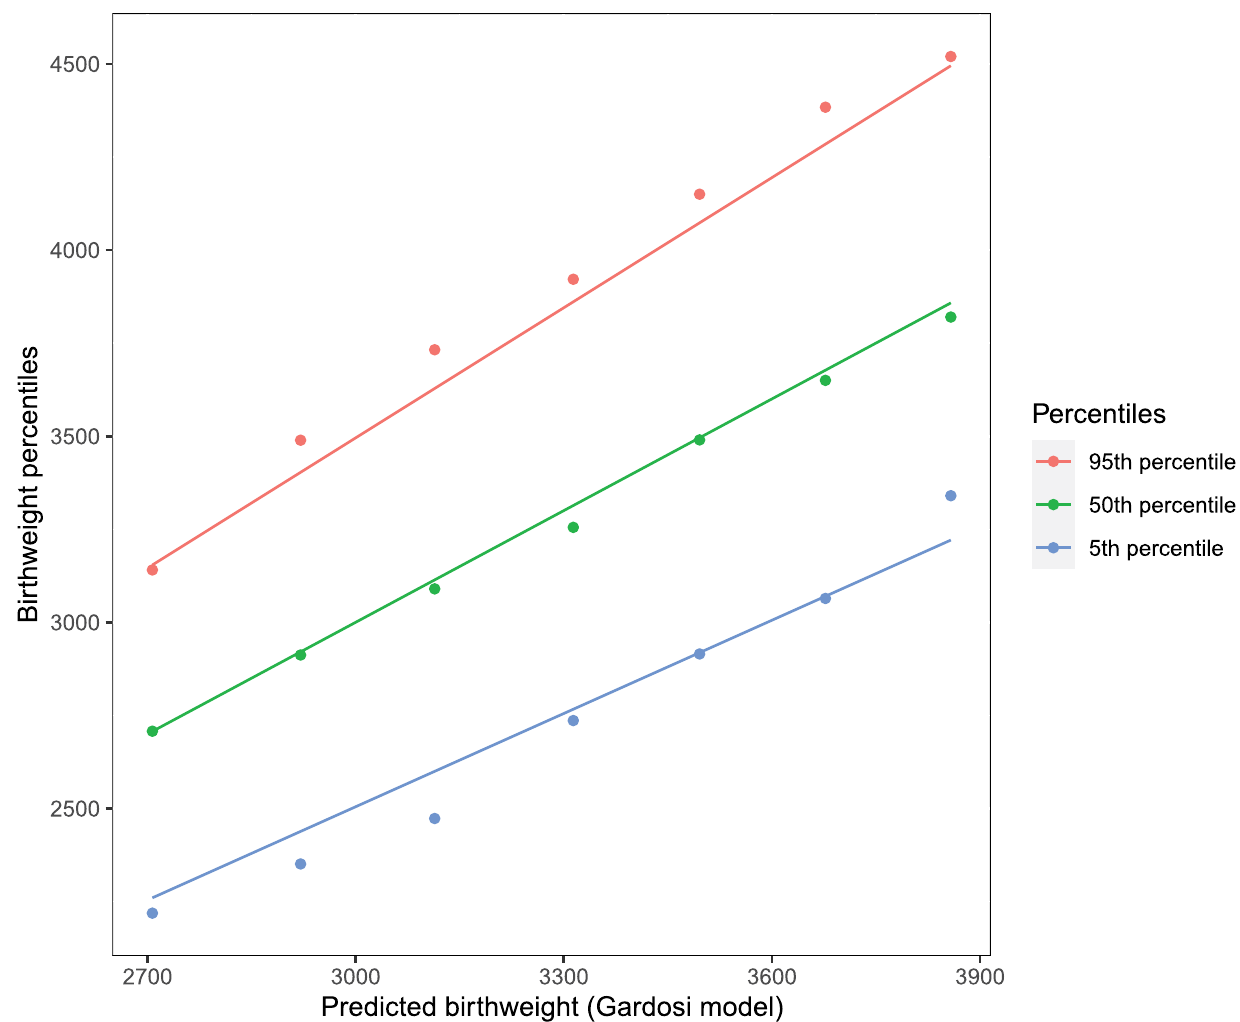
Fig 1. Empirical percentiles (5 th and 95 th ) of term optimal birthweight at different levels of mean birthweight are compared with the percentiles obtained from the Gardosi model which assumes normality and constant CV to compute the percentiles. Data are from the NICHD Fetal Growth Studies–Singleton. The lines are from the models while the points are empirical